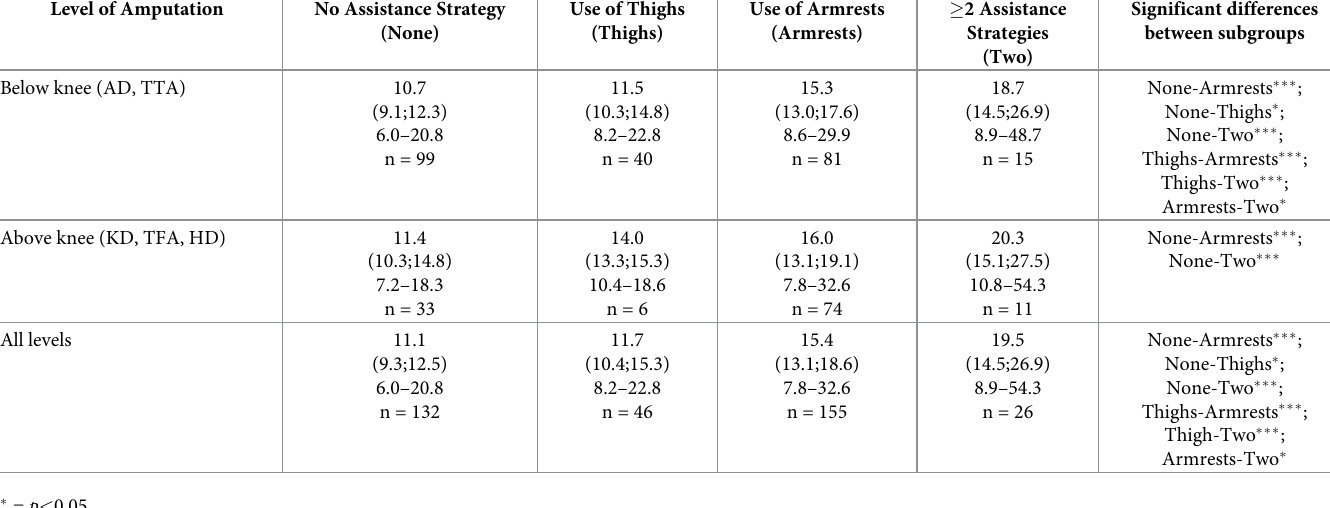
Table 3. The m5xSTS test times (seconds) by level of amputation and use of assistance strategy (n = 359 a ). Median and quartiles are provided for each subgroup in the following format: Median (75 th quartile;25 th quartile), minimum-maximum, and subgroup sample size. a The two participants who used the walker as their only assis- tance strategy were not included in these